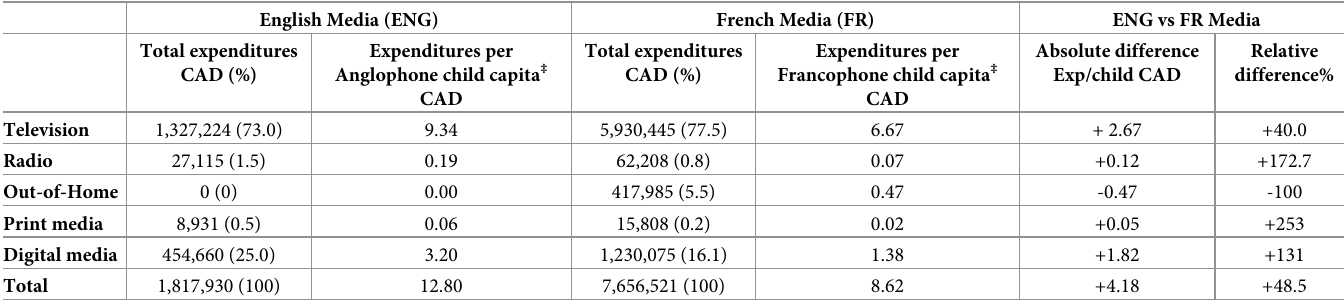
Table 6. Advertising expenditures on child-targeted products † in Quebec in 2019, by